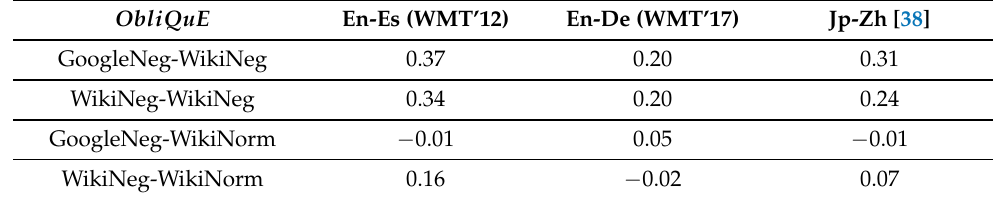
Table 3. Repeating the tests described in Table 1 with various pre-trained vector combinations. Each row corresponds to a specific pair of versions of a word2vec embedding. The text source and the negative sampling flag are embedded in the name of the version. The left-hand-side (lhs) version was used for the source language and the rhs for the